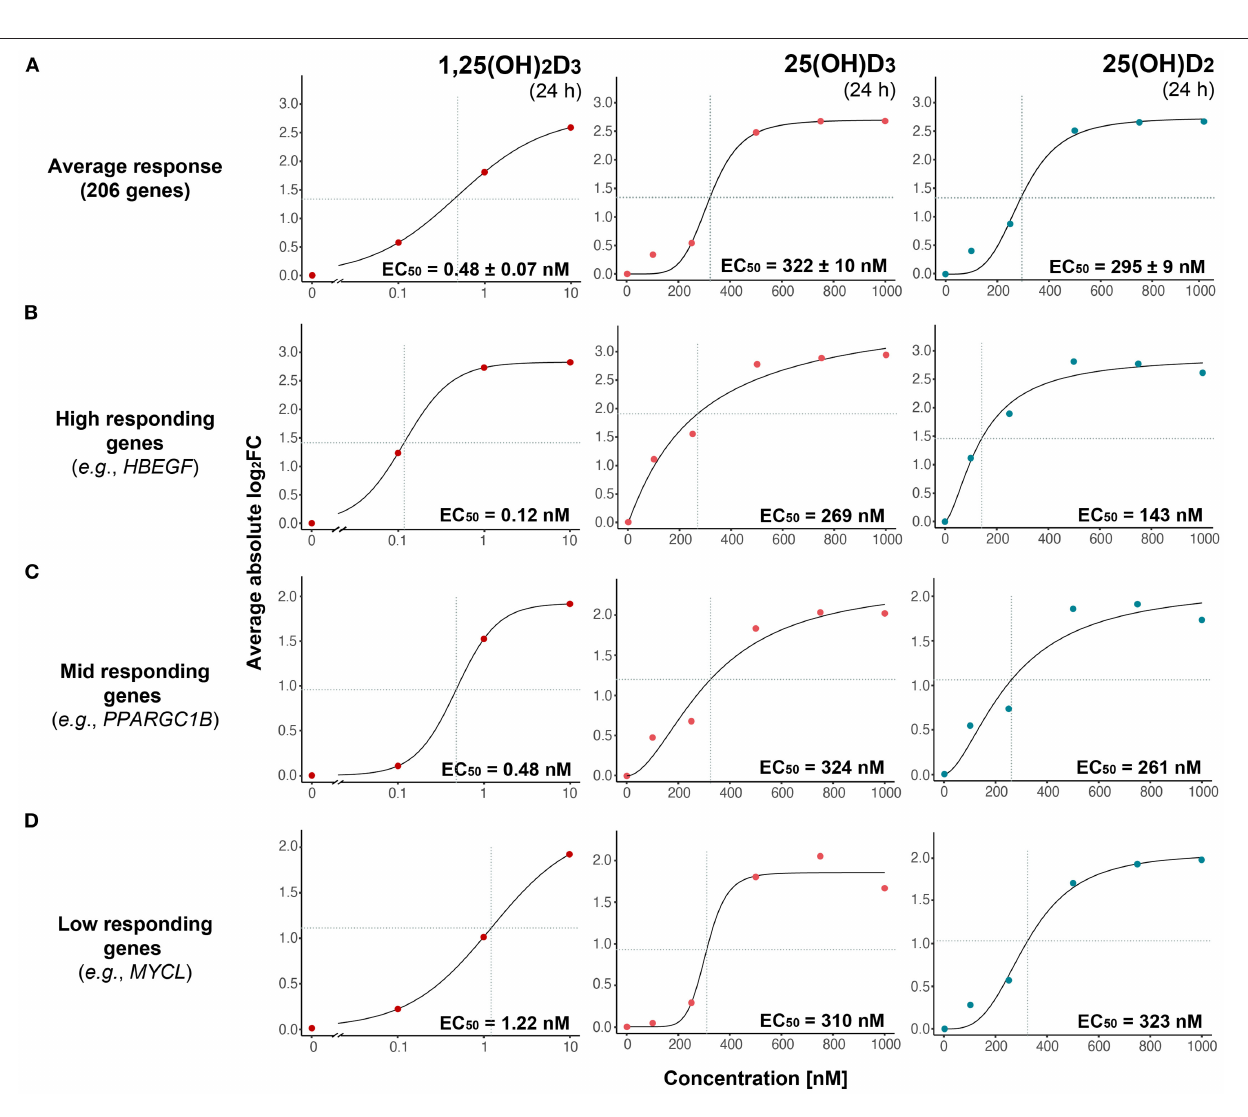
FIGURE 2 | Gene-specific response to vitamin D metabolites. The magnitude of expression change (absolute log 2 FC) as a function of vitamin D metabolite concentration is modeled with a three-parameter log-logistic model based on the average of 206 common targets (A) or indicated individual genes (B–D) . Genes are segregated into high-, mid- and low-responding based on their estimated EC 50 values in response to 1,25(OH) 2 D 3 . Standard errors of the EC 50 estimates are